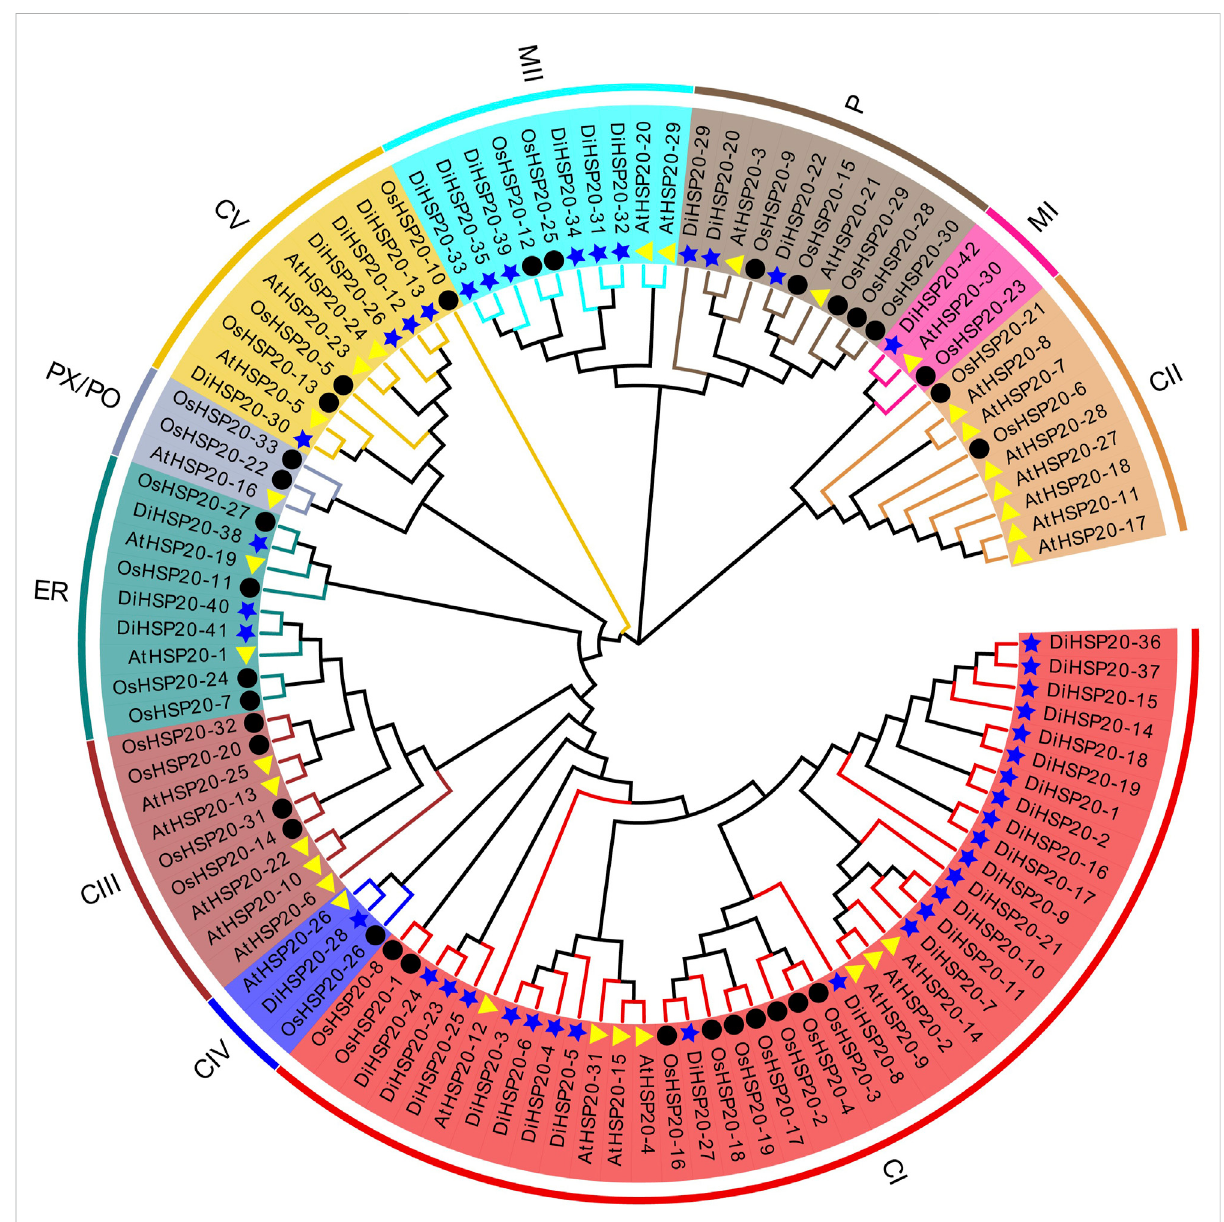
FIGURE 1 Phylogenetic analysisof Davidiainvolucrata , Arabidopsis ,andriceHSP20sproteins.MEGA-Xsoftwarewasusedtocreateaphylogenetictreeof HSP20 proteins. The ten subgroups are denoted by various colors. D. involucrata HSP20s ( DiHSP20 s), Arabidopsis HSP20s ( AtHSP20 s), and rice HSP20s ( OsHSP20 s) are shown by blue stars, yellow triangles, and black circles,